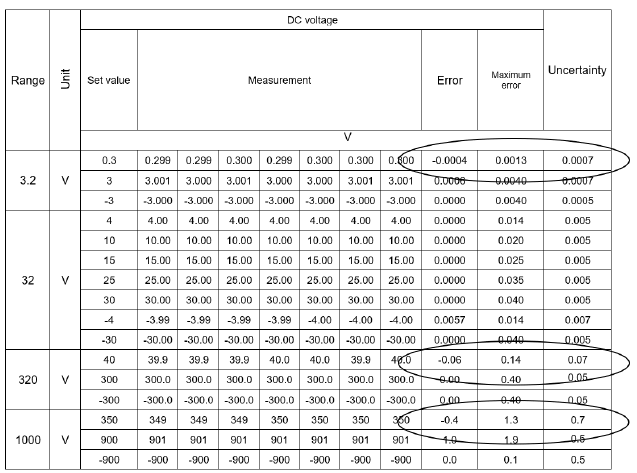
Figure 12. The result of optimization calculations with three methods for the point 40 V